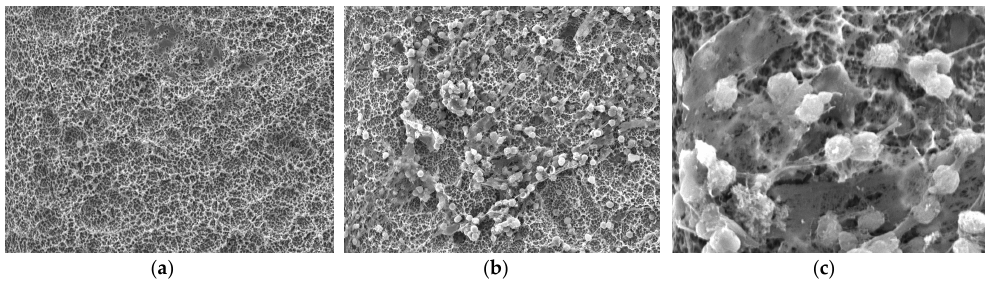
Figure 4. ( a ) SEM photograph at 500× magnification, showing clustered neutrophils on an MR disc, post PMA activation, with lack of cellular morphology and adaptation. ( b ) SEM image at 500× magnification showing clustered neutrophils on a CMR surface disc, post PMA activation, showing intact cellular morphology. ( c ) SEM image at 2500× magnification on a CMR disc showing intact